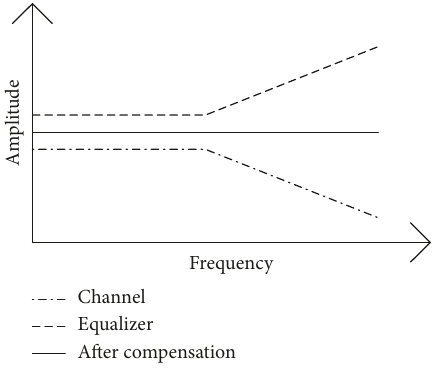
Figure 1: Channel frequency